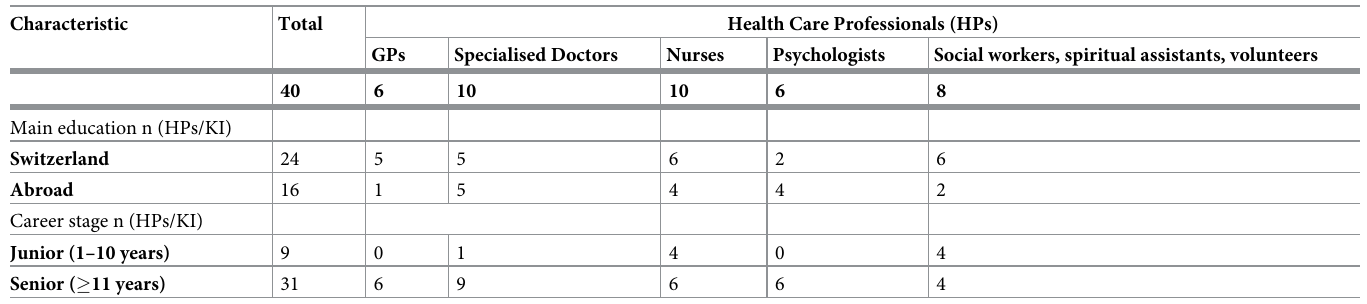
interdisciplinary (between oncologists and PC providers) collaboration. These themes were organized into two main areas—interactional and organizational barriers and facilitators.